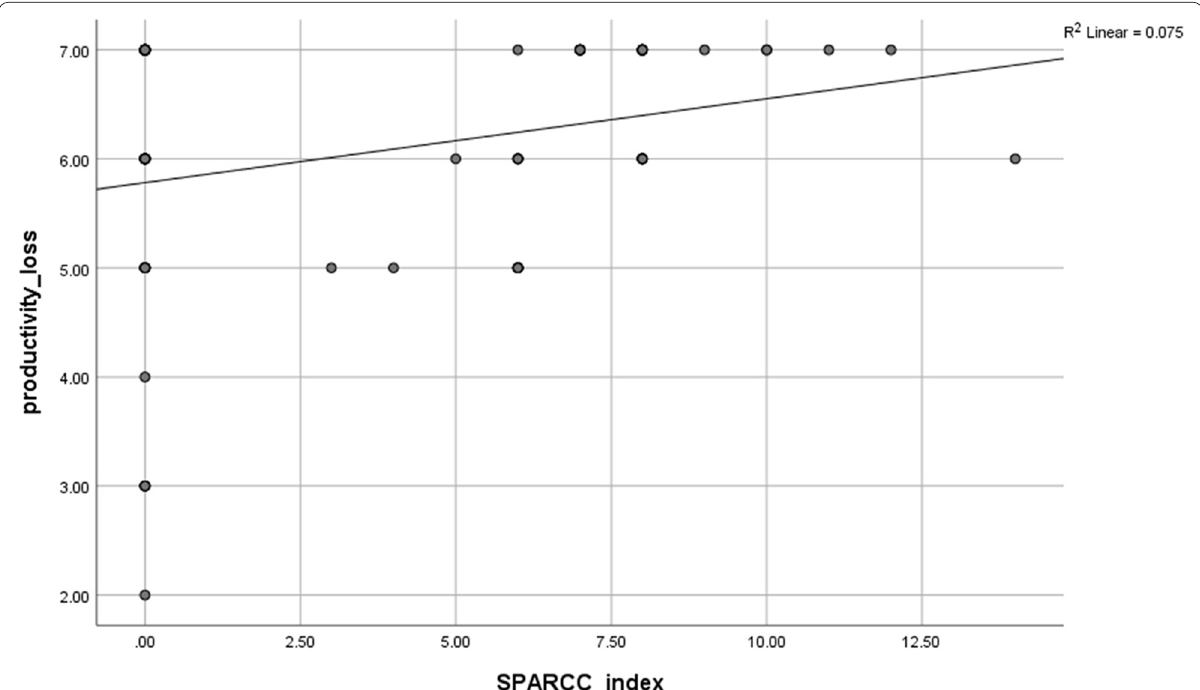
Fig. 2 Correlation between SPARCC index and work productivity